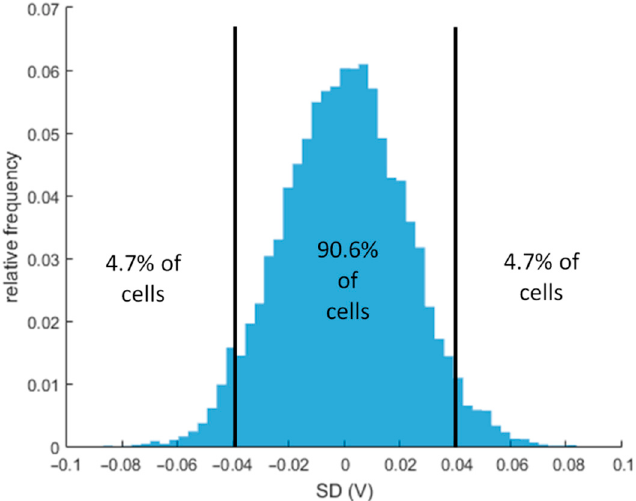
Figure 5. Histogram of the relative frequency of cells as a function of the SD parameter obtained from Monte Carlo analysis.